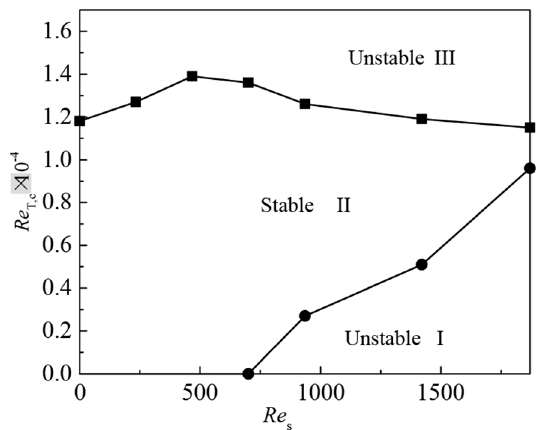
Figure 6. Critical conditions for the iso-rotation of crystal and crucible.